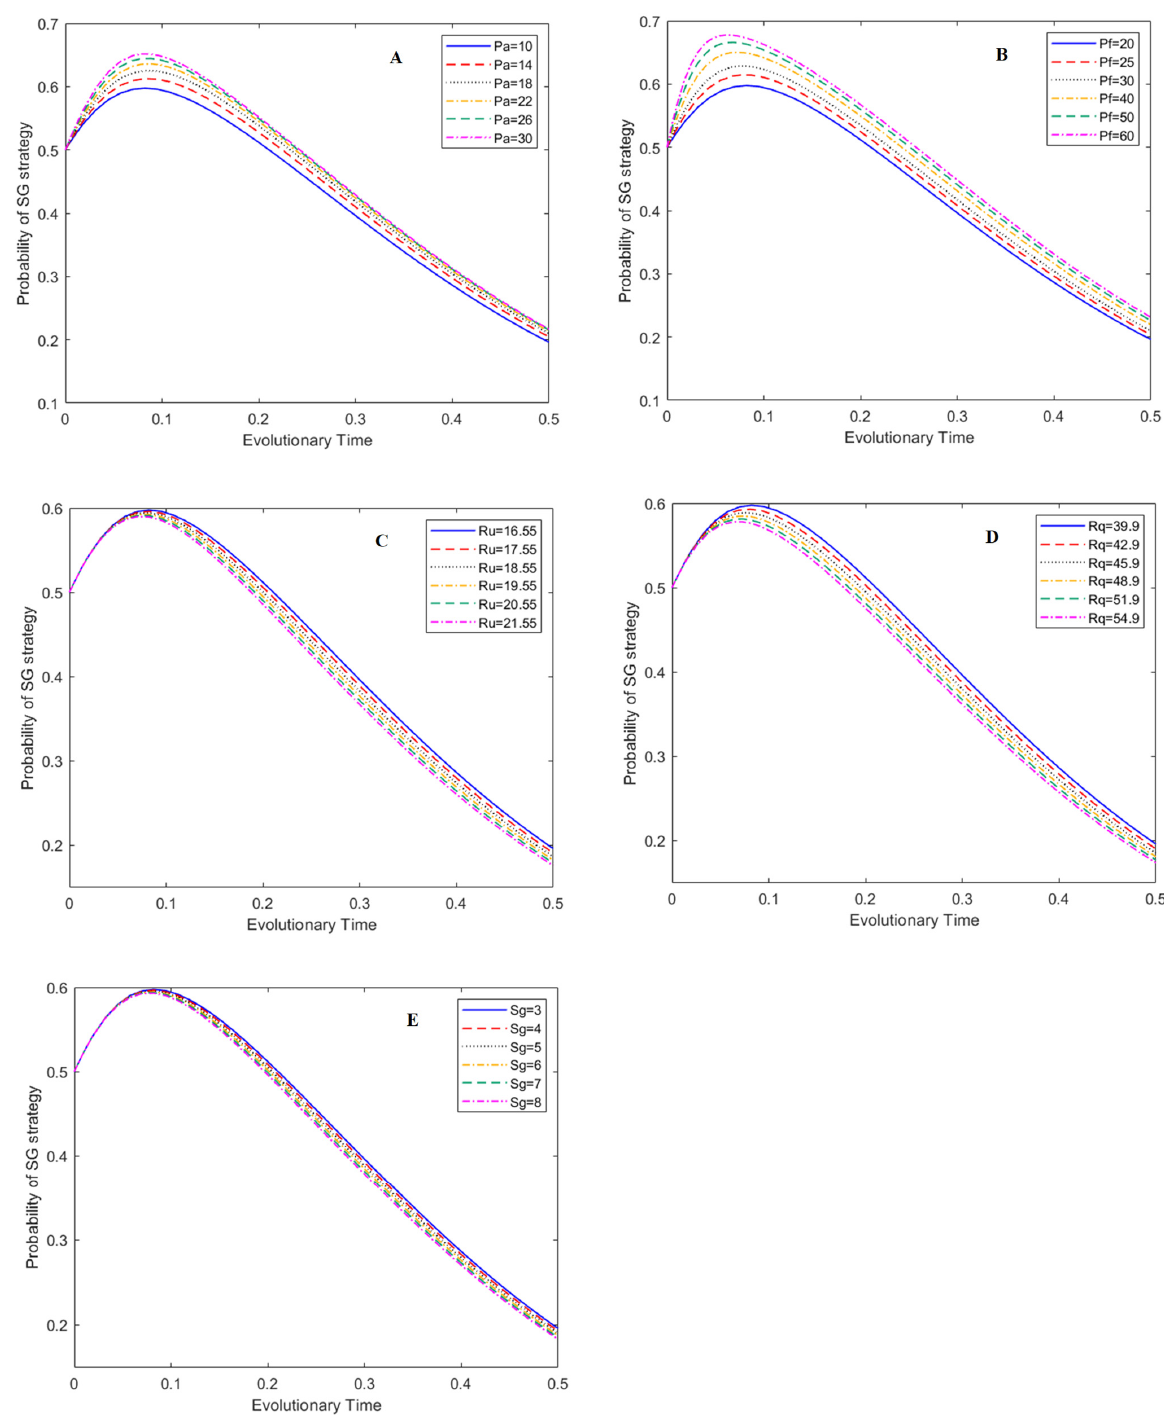
Figure 6. Effects of main parameters on the evolution of SG strategy under (1,1,0), subfigures A–E represent the effects of P a , P f , R u , R q , and S g on the evolution of SG strategies, respectively.